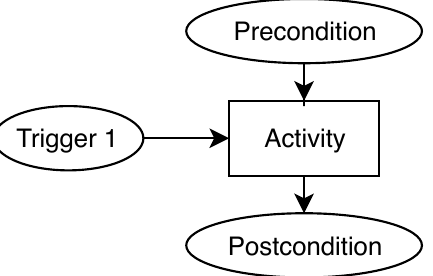
Figure 7. Mapping a behavior interface model to a CPN model—based on [66,67]. The complete and formalized Rechained CPN model as derived from the AOM goal model and the AOM behavior interfaces and implemented using CPN-Tools is shown in Figure 8.